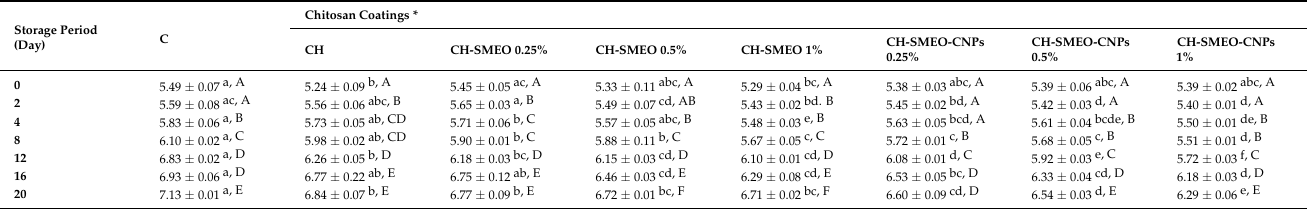
Table 7. Change in pH value in beef samples treated with chitosan coatings and chitosan-based nanoparticles with the addition of Satureja montana L. essential